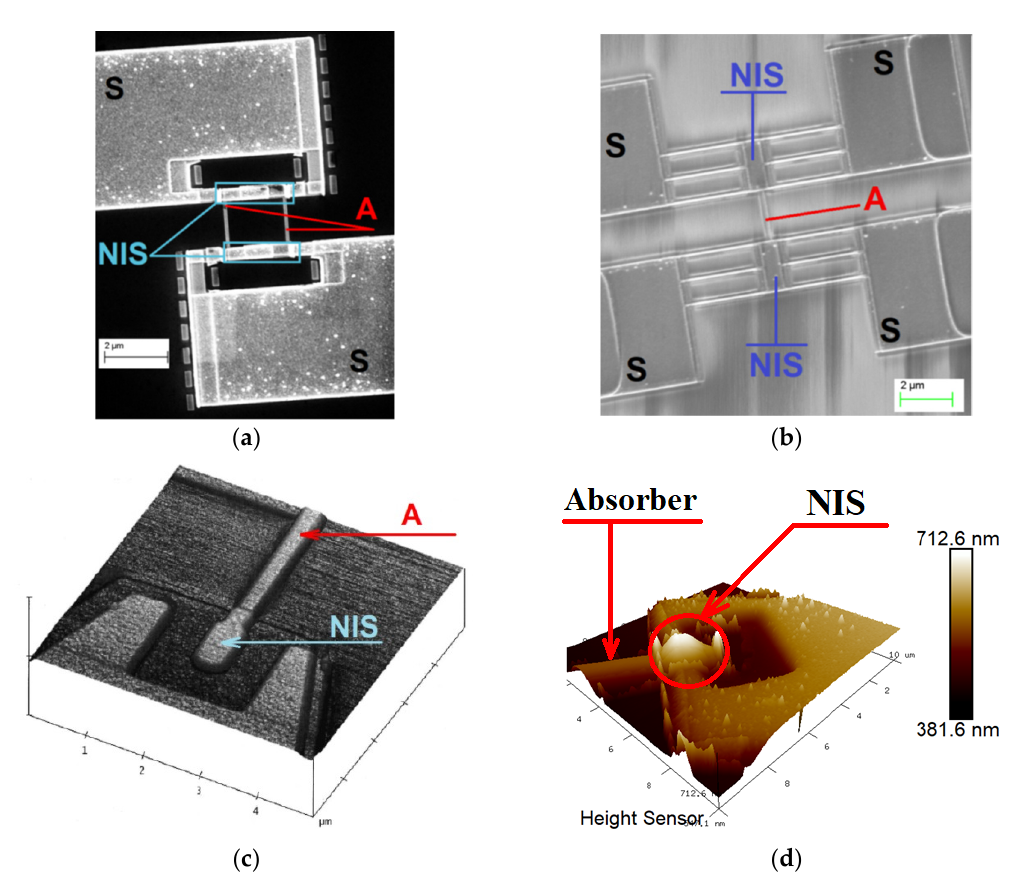
Figure 8. Photos of samples fabricated via different technologies (A—absorber; NIS—normal metal– insulator–superconductor tunnel junction; S—superconducting electrodes): ( a ) Dolan’s technique; ( b ) bridge-free technology; ( c ) direct-write trilayer technology; ( d ) direct-write separate lithography technology with magnetron sputtering.